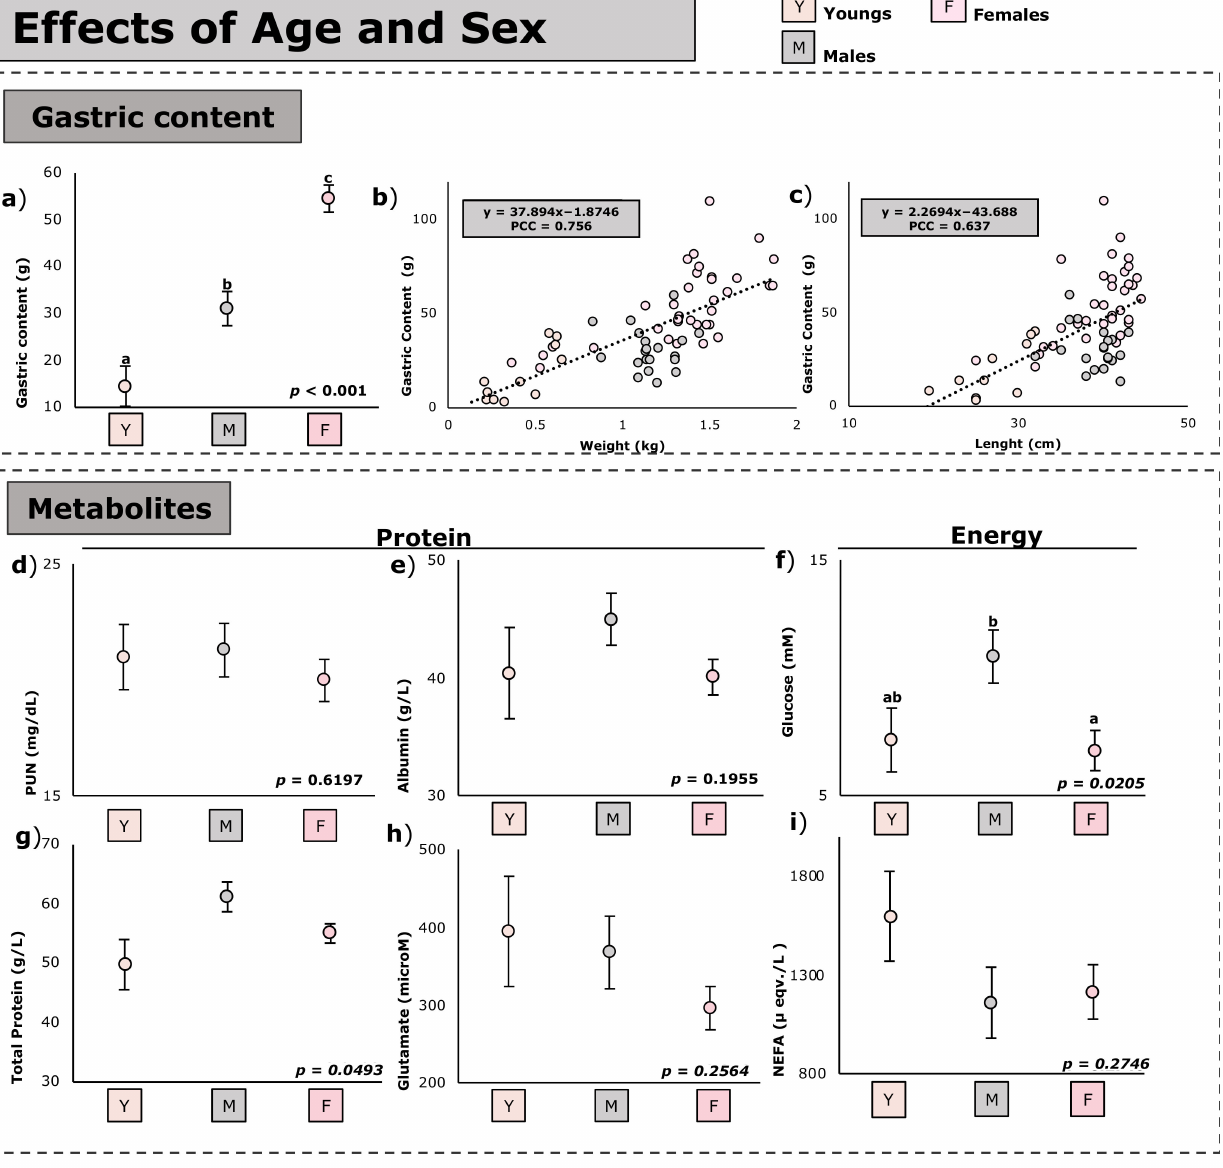
Figure 1. Effect of age and sex on the full stomach contents and nutritional metabolites of Oryctolagus cuniculus ( n = 89). Least square means ± standard errors, ( a – c ) Least square means in the same graph with no common superscripts differ significantly at p < 0.05 ( a , d – i ). Relationship between digestive contents weight and biometric measures, i.e., animal body weight (Figure 2b) and animal length ( c ); PCC, Pearson correlation coefficient; NEFA, non-esterified fatty acids; PUN, plasma urea